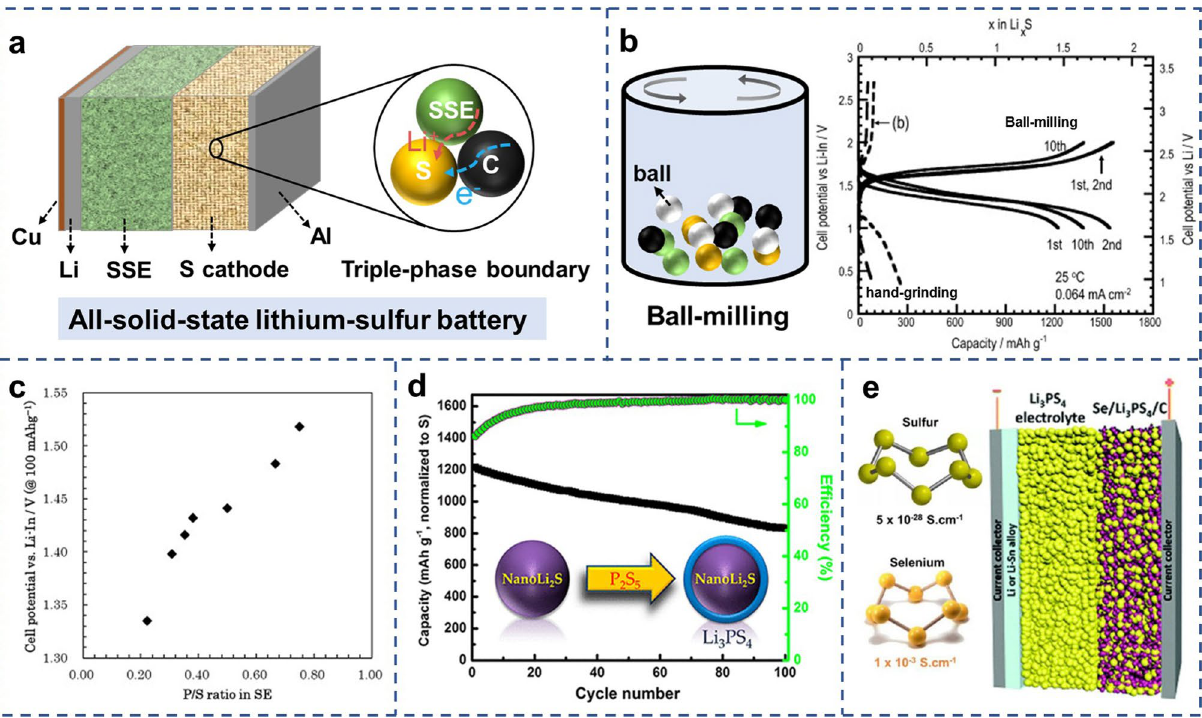
Fig. 1 a Schematic illustration of all-solid-state lithium–sulfur battery. b Charge–discharge curves of all-solid-state cells of Li– In/0.8Li 2 S·0.2P 2 S 5 /S using hand-grinding and ball-milling. Copyright from Ref. [28]. c Plots of the discharge potentials for various P/S ratios in SSEs. Copyright from Ref. [32]. d Electrochemical evaluation of NanoLi 2 S as the cathode material for ASSLSBs at 60 ℃ . Copyright from Ref. [35]. e Illustration of all-solid-state Li-Se batteries highlighting the significantly higher electronic conductivity of selenium compared to that of elemental sulfur. Copyright from Ref.